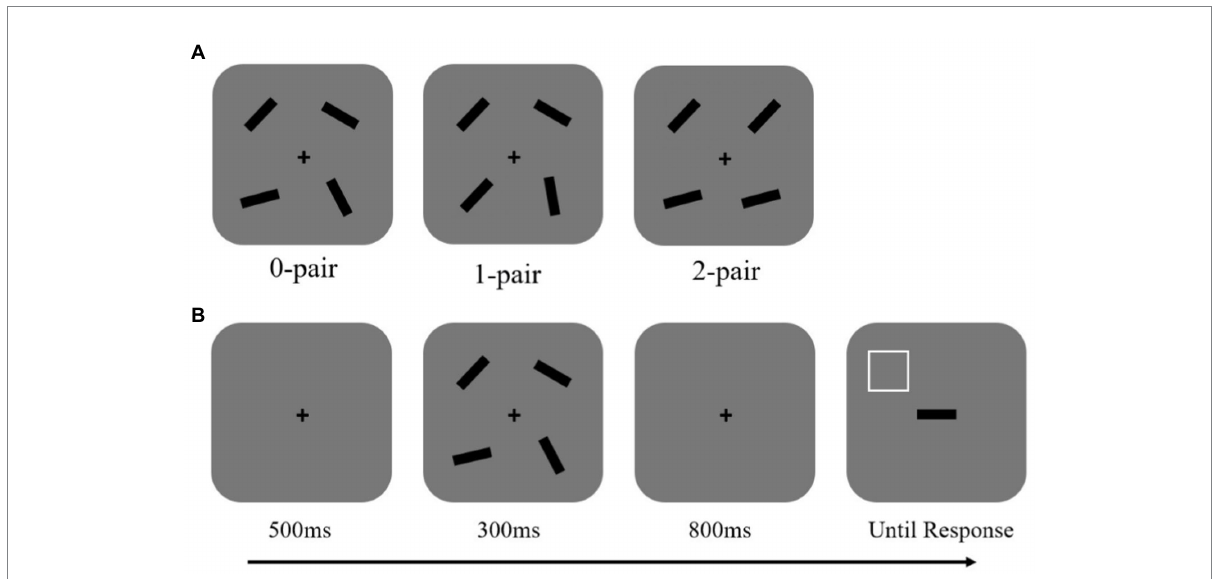
FIGURE 1 (A) Spatial configuration of memory items in Experiment 1. There were three conditions: 0-pair condition, 1-pair condition, and 2-pair condition. (B) The schematic of the experimental procedure. The white square outline was used as a cue to instruct participants to recall the orientation of the bar, which previously appeared at that cued